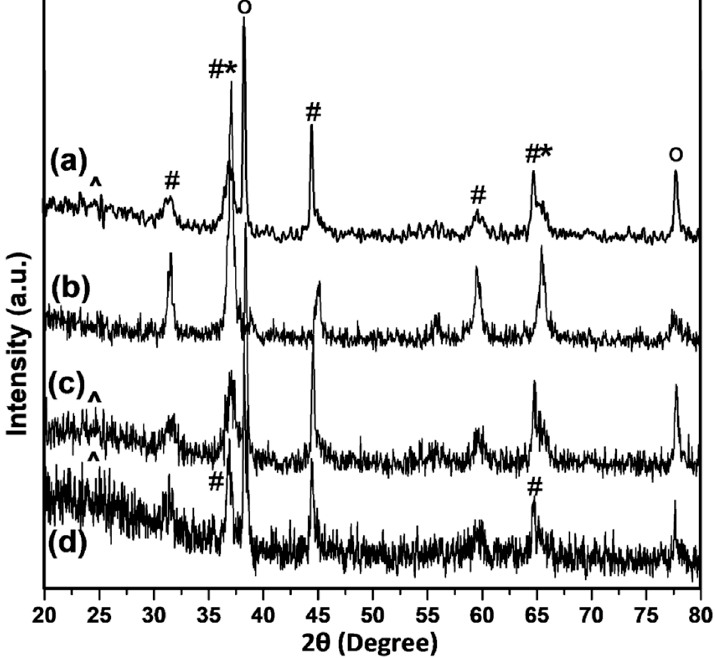
Figure 3. X-ray powder diffraction ( XRD) patterns for the calcined of catalysts: ( a ) Co/NS-Al-B, ( b ) Co/Al 2 O 3 , ( c ) Co/NS-Al-A and ( d ) Co/NS catalysts. (*) CoAl 2 O 4 ; (#) Co 3 O 4 ; (^) SiO 2 ; and (o) Co.